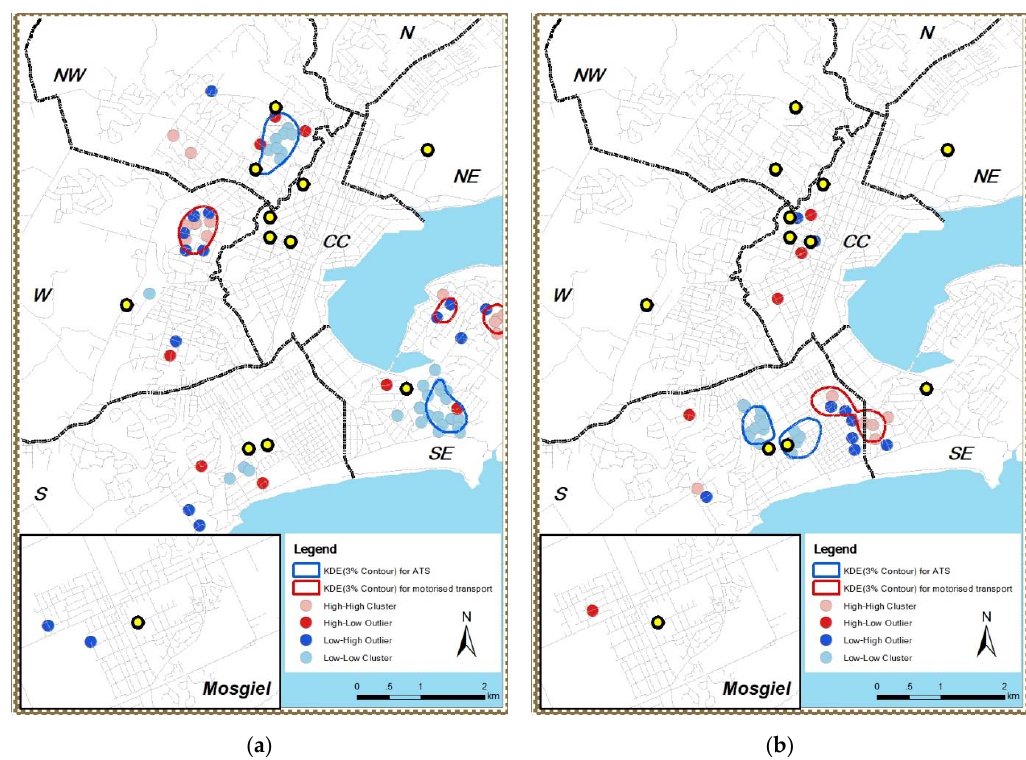
Figure 3 . KDE and LISA transport modes distribution on home deprivation index: ( a ) less deprived home neighbourhood; ( b ) more deprived home neighbourhood.